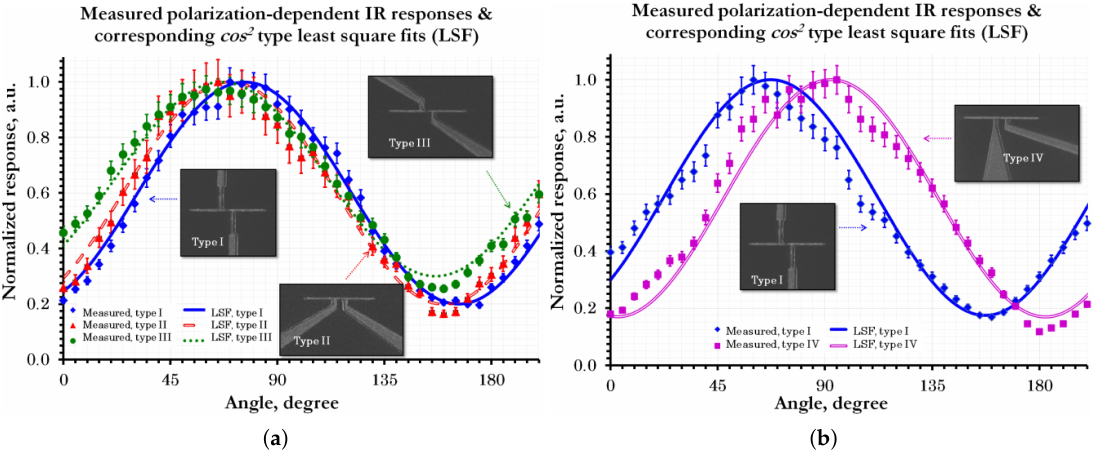
Figure 4. Polarization dependent measured responses of the ACMOMDs together with the corresponding cos 2 -type fits for different configurations of read-out interconnect designs: ( a ) Symmetrical configurations, ( b ) Asymmetrical configuration